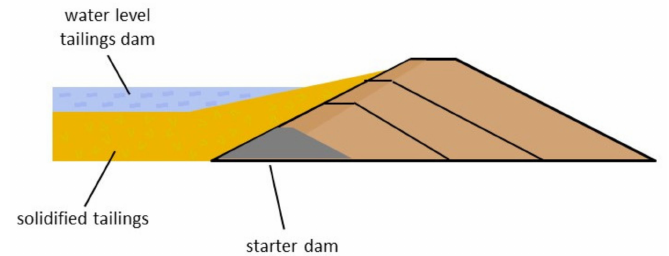
Figure 16. Schematic diagram of the structure of a tailings